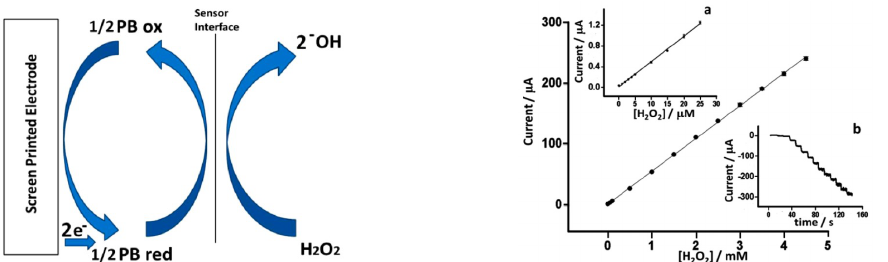
Figure 3. Electrochemical characterization of the electrodes with electrodeposited Prussian blue nanoparticles (PBNPs) layers. ( Left ) mechanism of the catalytic H 2 O 2 reduction mediated by Prussian blue (PB), ( Right ) calibration curve of H 2 O 2 on PBNP screen printed electrodes (SPEs). ( a ) Detail in the concentration range between 0 and 25 µ M and ( b ) raw amperometric data from 0 to 4.5 mM. With permission from